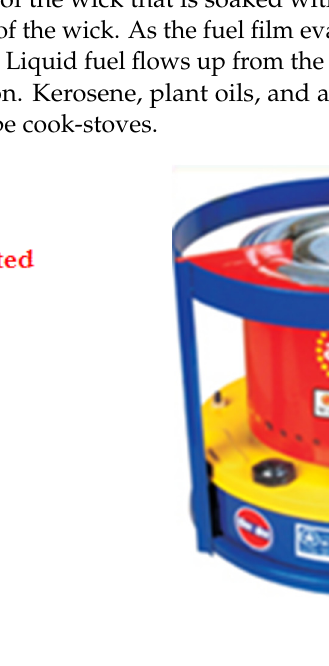
Figure 4. Schematic of wick type ( a ) burner and ( b ) cook-stove.